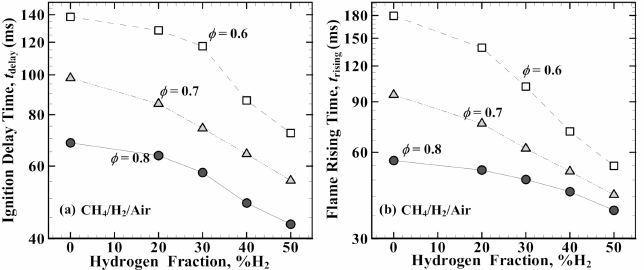
Figure 8. Effect of hydrogen volume fraction on ( a ) t delay and ( b ) t rising of lean CH 4 /air mixtures at three equivalence ratios of 0.6, 0.7, and